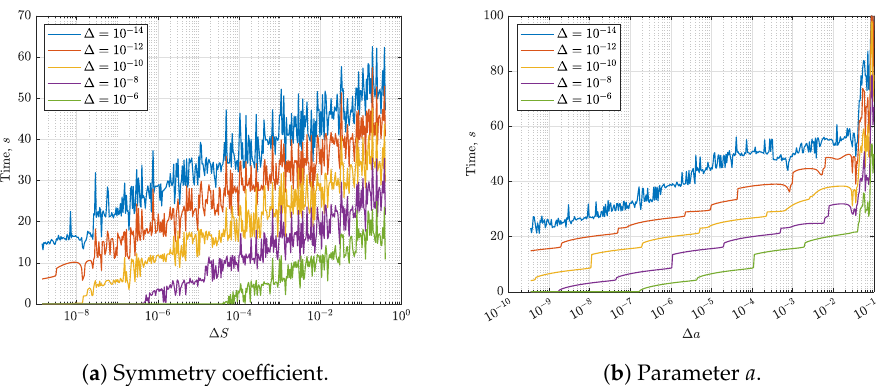
Figure 7. Dependence of synchronization time from the threshold synchronization error ∆ x